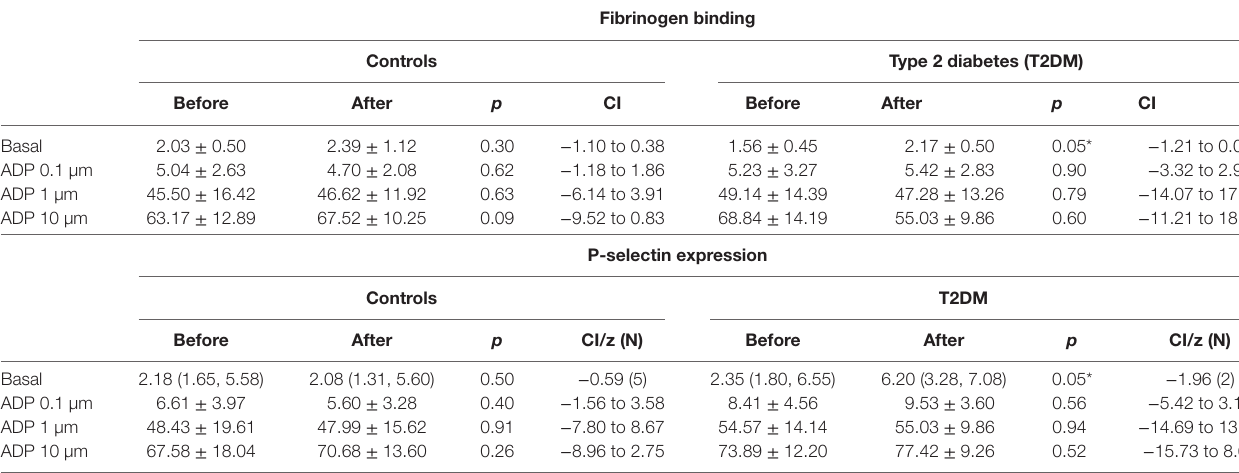
Table 3 | Platelet activation and response to ADP prior to and after the relative hypoxia of the simulated flight (SF) intervention.